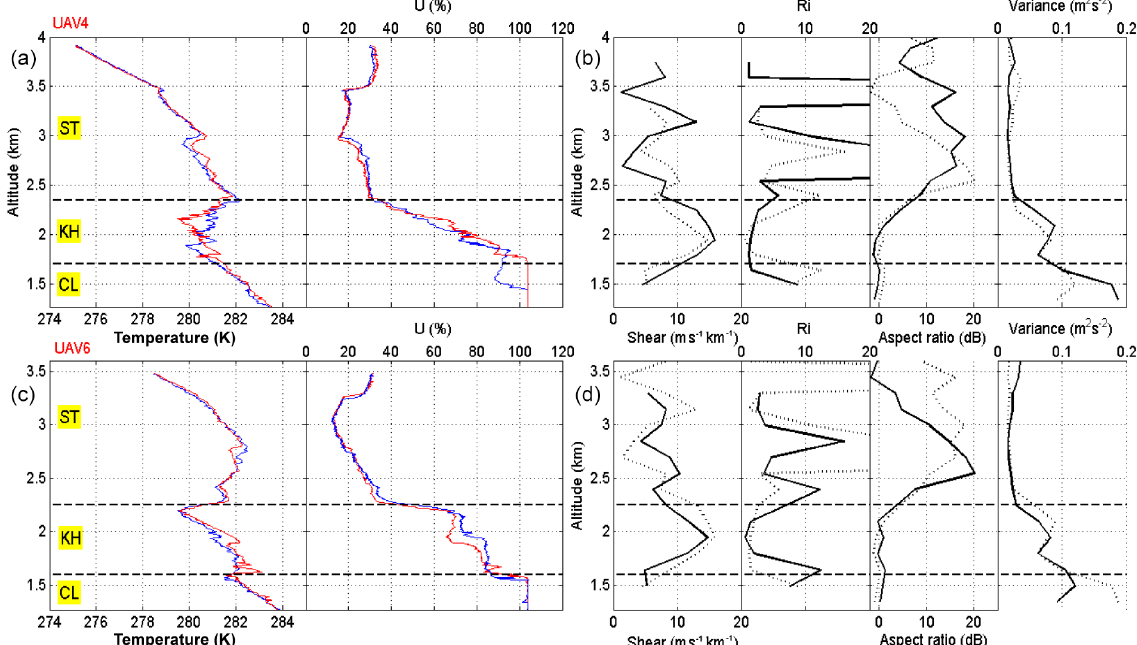
Figure 4. (a, b) From left to right: temperature and humidity profiles during ascent (blue) and descent (red) of UAV4, vertical profiles of horizontal wind shear, Richardson number, radar aspect sensitivity and the turbulent contribution to the variance of Doppler spectra. (c, d) Same information but for flight UAV6. The labels CL, KH and ST and horizontal dashed lines refer to altitude ranges discussed in the text. For easy comparisons between the two flights, the dotted profiles for UAV4 (UAV6) show the profiles obtained from UAV6